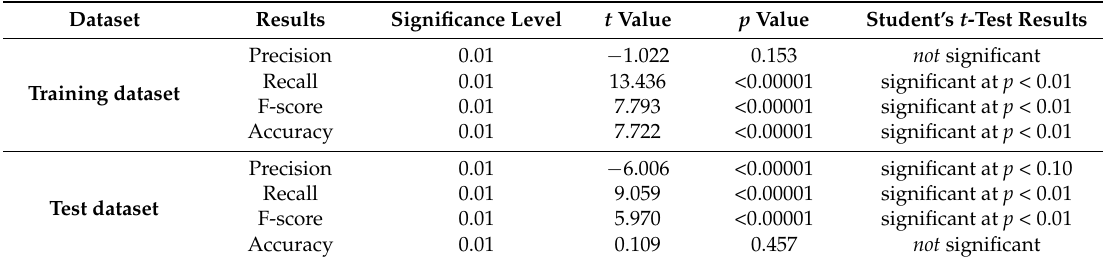
Table 10. Student’s t -tests based on the training and test